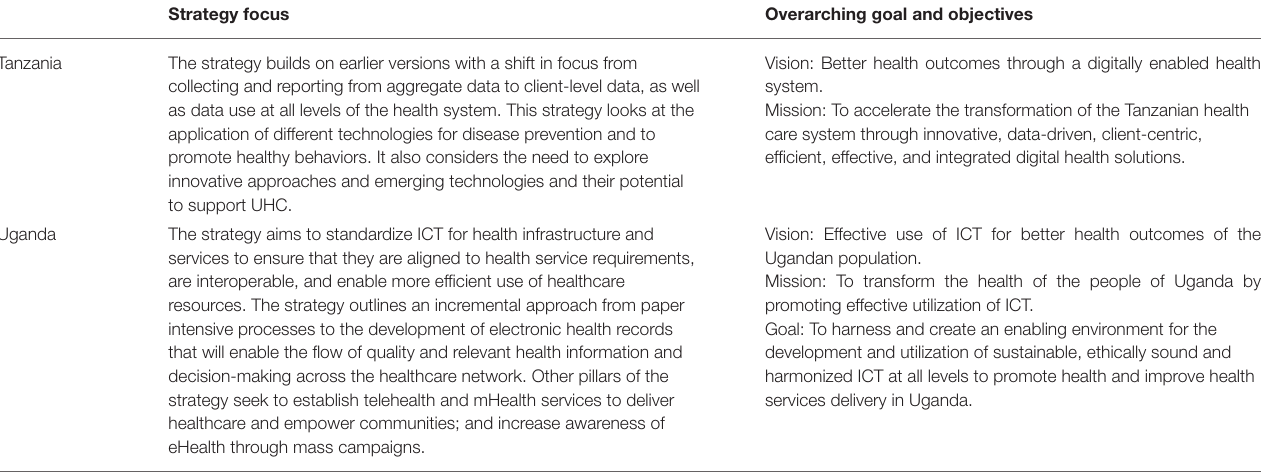
TABLE 4 | Focus on children and youth within digital health strategies. High youth population noted